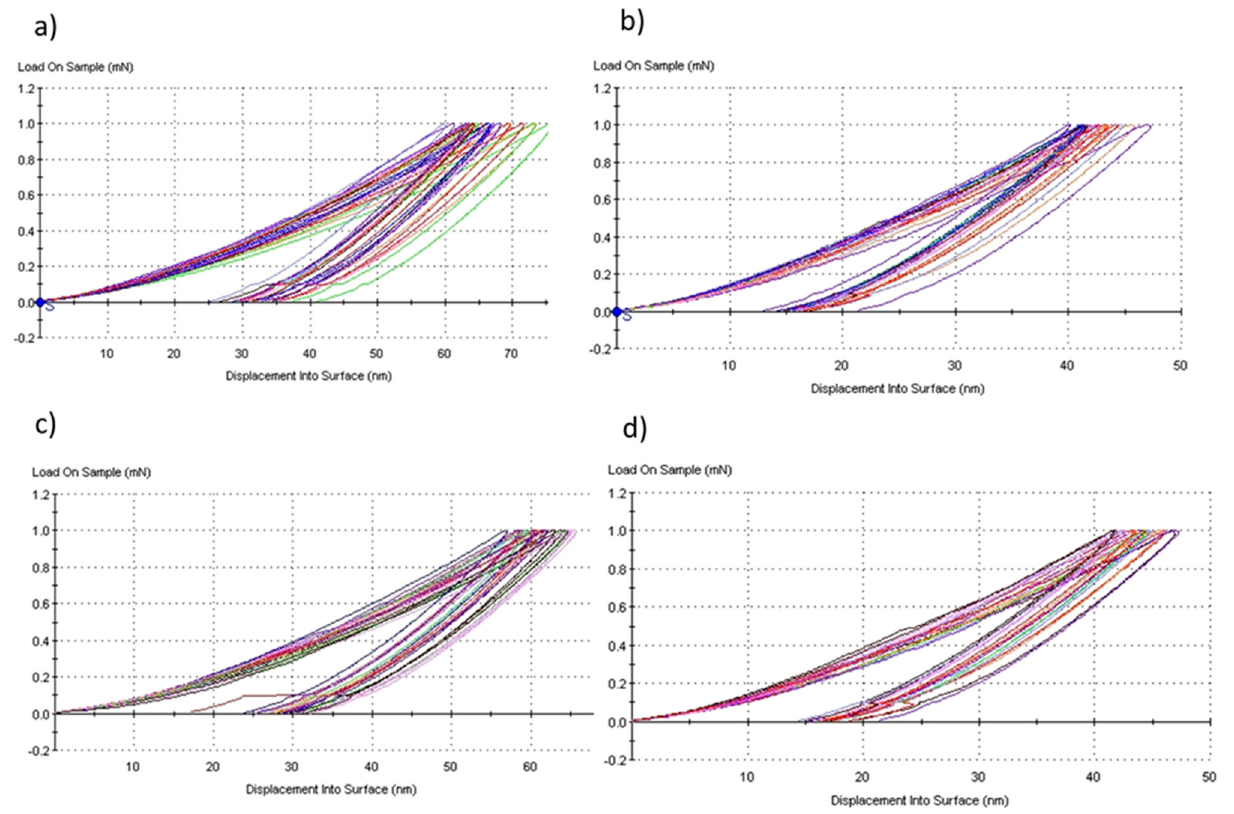
Figure 15. Load versus displacement into surface characteristics curves for coatings method, ( a ) HA10BT − S, ( b ) HA50BT − S, ( c ) HA10BT − MB, and ( d ) HA50BT − MB.